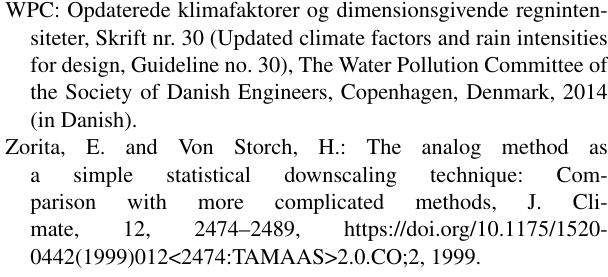
WPC: Opdaterede klimafaktorer og dimensionsgivende